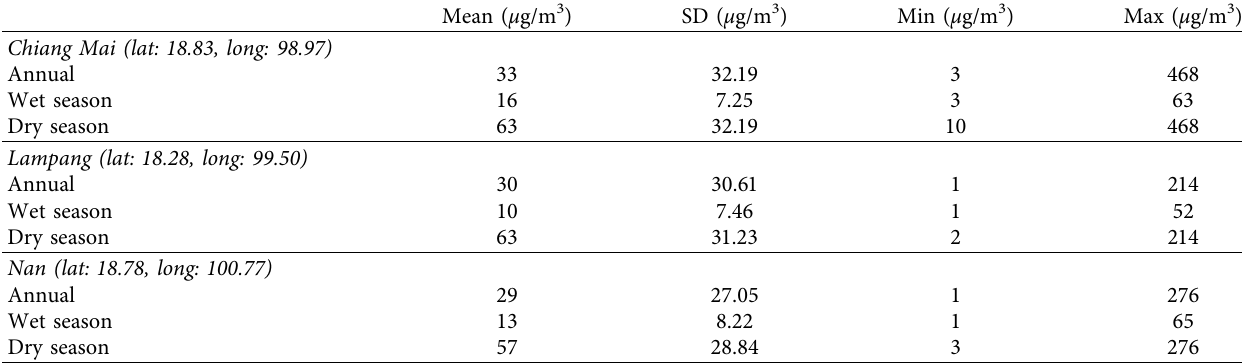
2.5 monitoring stations (red triangles). 2.5 observations in Northern